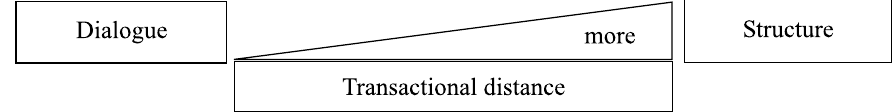
Figure 1. Relationship between dialogue and